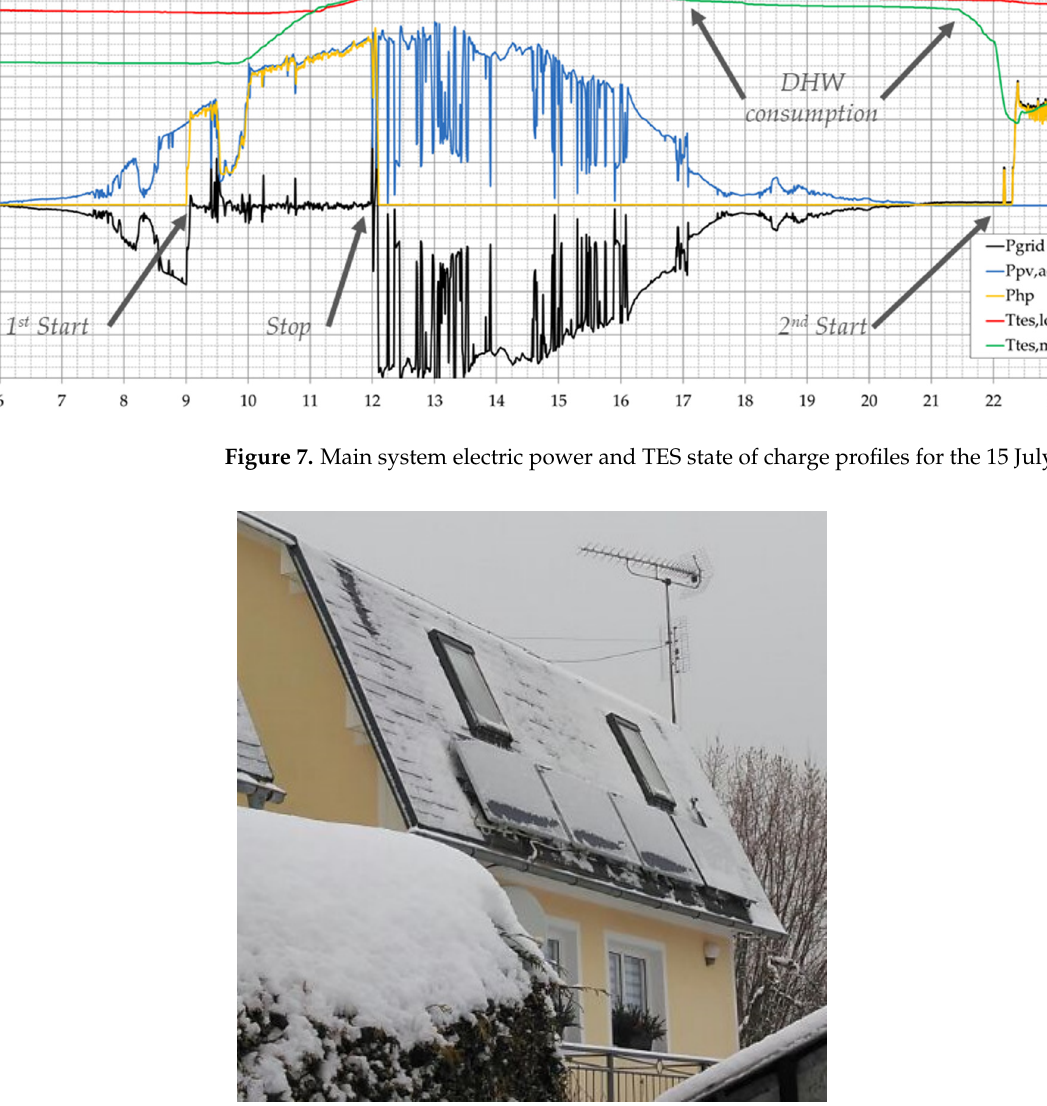
Figure 8. The single-family house for a typical winter season day, with the PVT collectors starting to melt earlier the snow compared to the PV module.